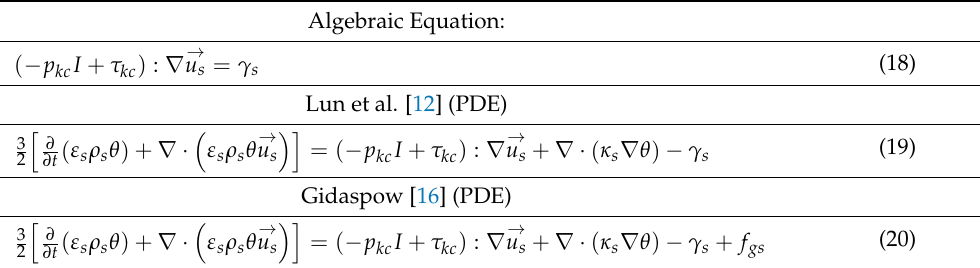
Table 5. Granular temperature equation.